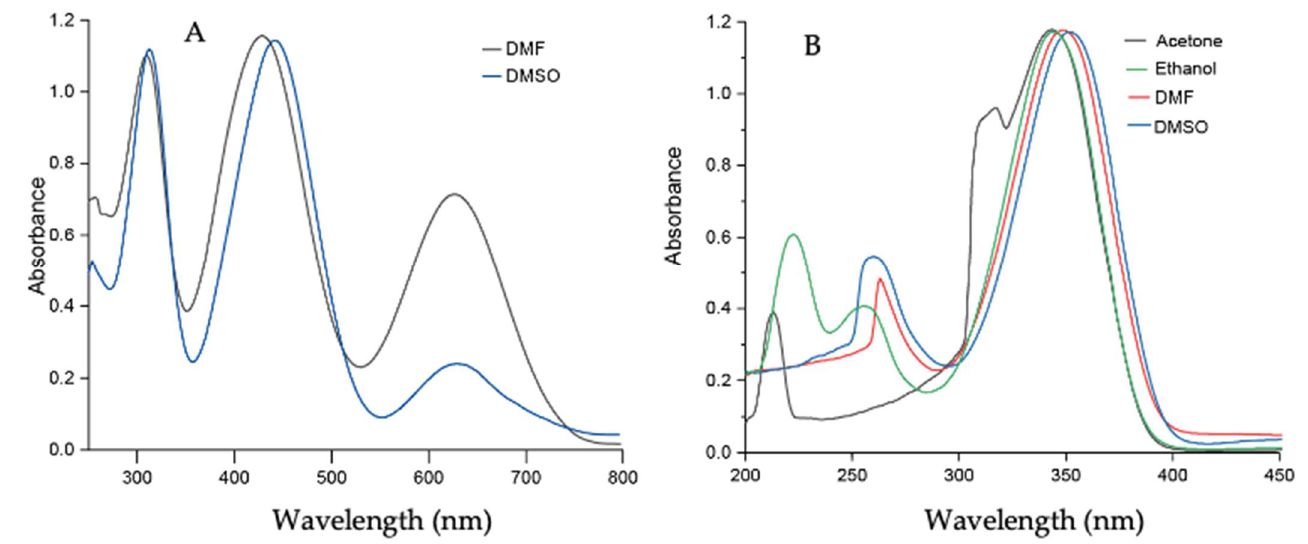
Figure 8. UV–vis spectrum of ( A ) Comp1 (0.5 × 10 −5 M) in DMF and DMSO; ( B ) Comp2 (0.5 × 10 −5 M) in acetone, ethanol, DMF, and DMSO.